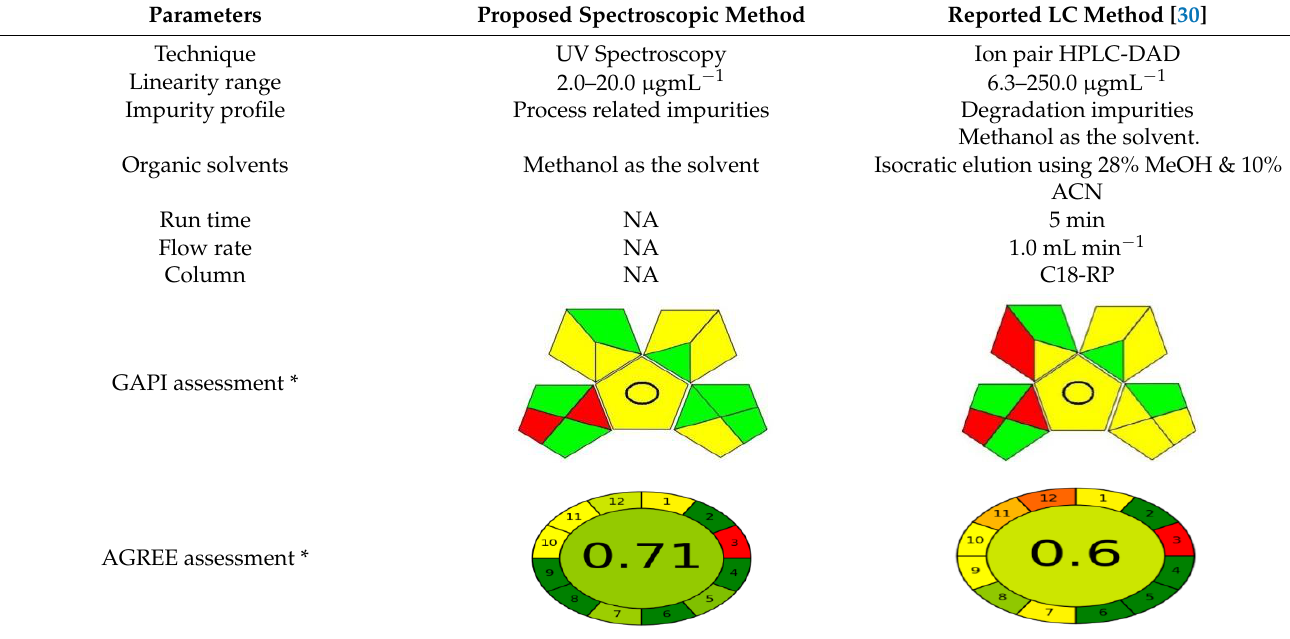
* According to the used greenness metrics, the ecological impact ranges from highest (red color), medium (yellow color), to lowest (green color).